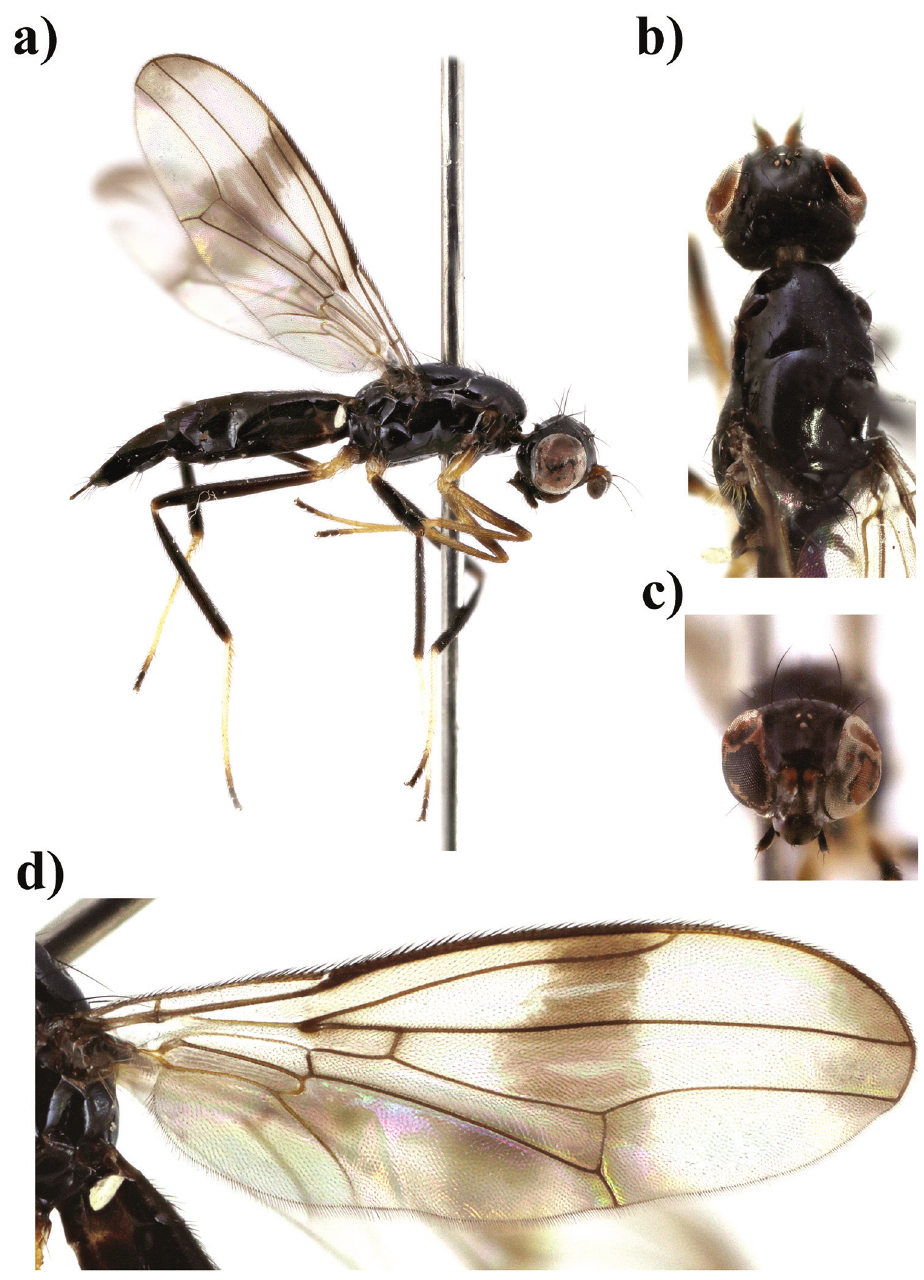
Figure 5. Strongylophthalmyia obtecta sp. n. a habitus, lateral view b head and thorax, dorsal view c head, anterior view d